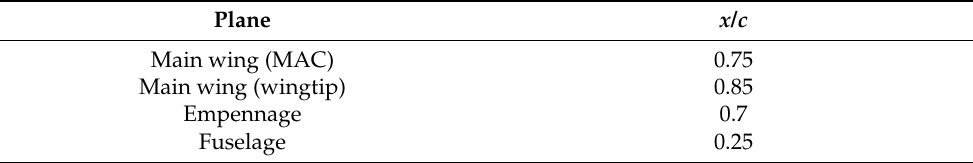
Table 3. Boundary layer transition points to fully turbulent for the examined planes of the